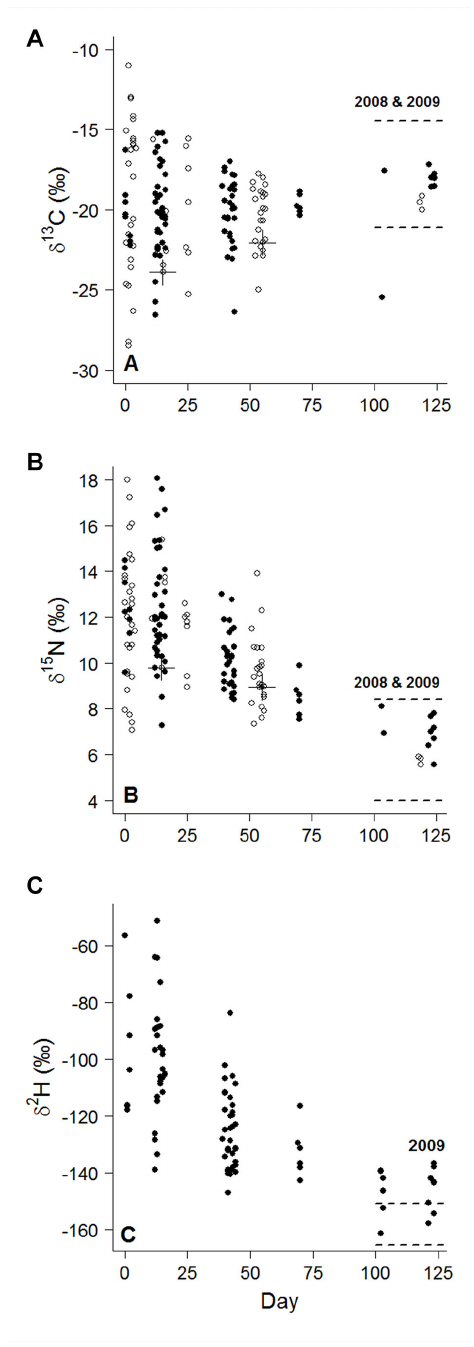
Figure 2. Isotopic composition of claw tips for Lesser Scaup sampled from May–September 2008 (open circles) and 2009 (closed circles) at Red Rock Lakes National Wildlife Refuge, Montana, U.S.A. Isotope values for adult female feathers (adjusted to claw tips) grown on the breeding grounds in 2008 and 2009 are denoted by dashed lines (2 SD). Day 0 (initial capture date) corresponds to 9 May in 2008